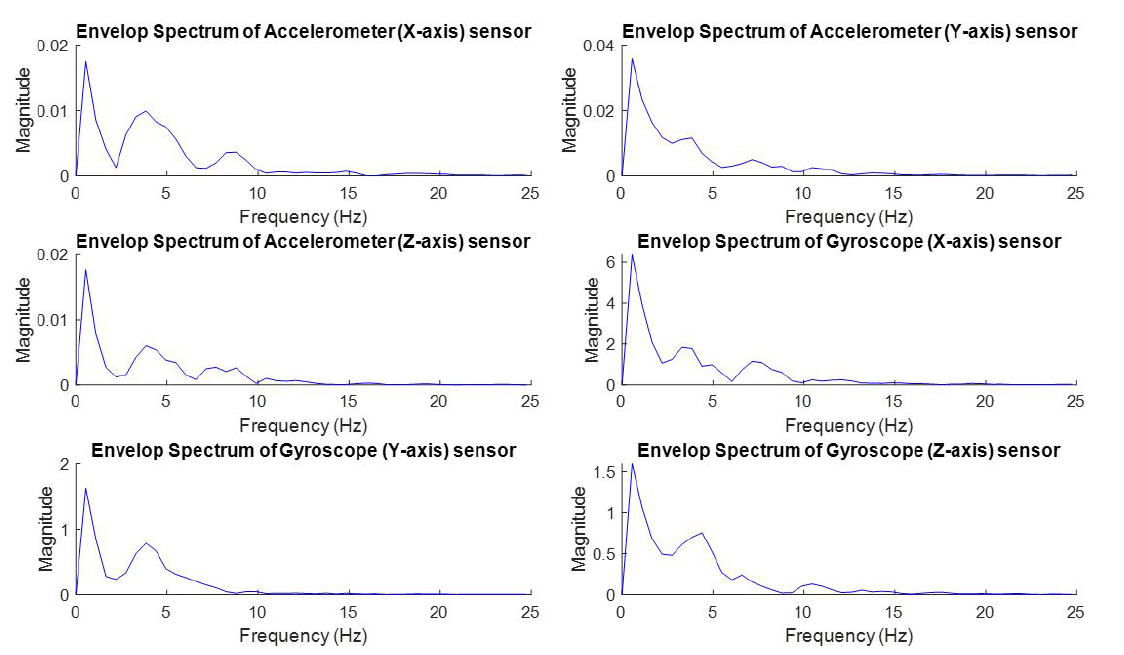
Figure 11. Example of envelope spectrum of accelerometer and gyroscope